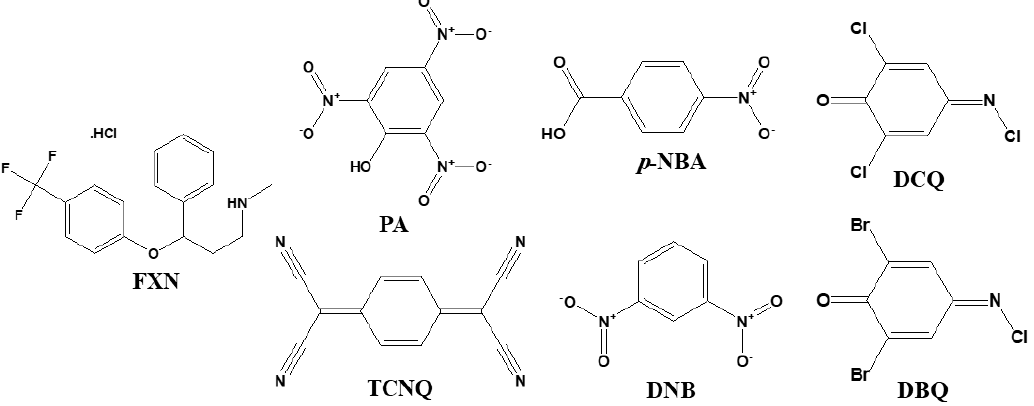
Figure 20. Structures of fluoxetin HCl (FXN) and six π -acceptors.